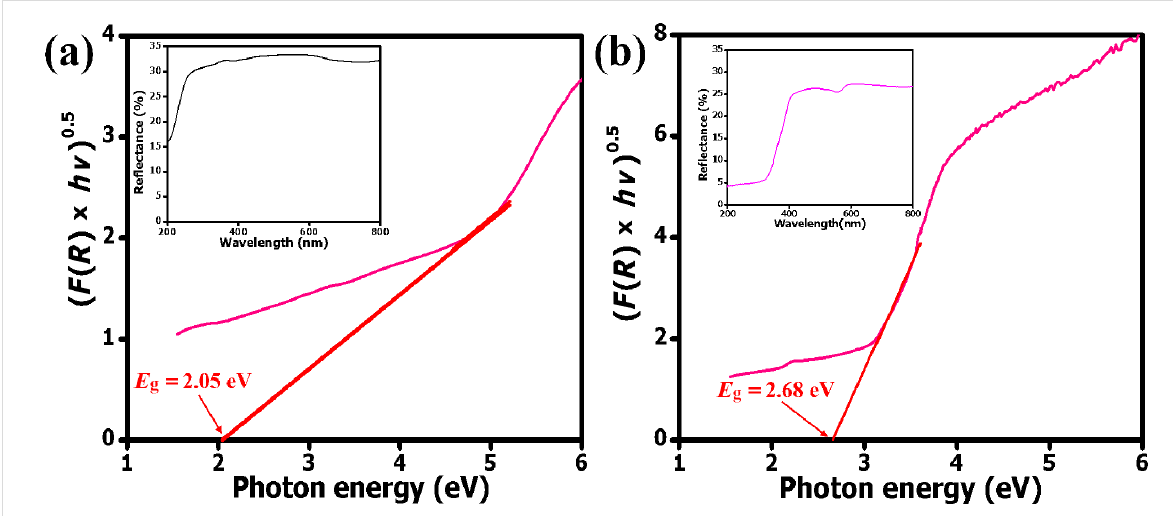
Figure 3: Indirect bandgap transition and diffuse reflectance UV–vis spectra (inset) of (a) mSiO 2 @NiPS and (b) mSiO 2 @NiPs/TiO 2 .